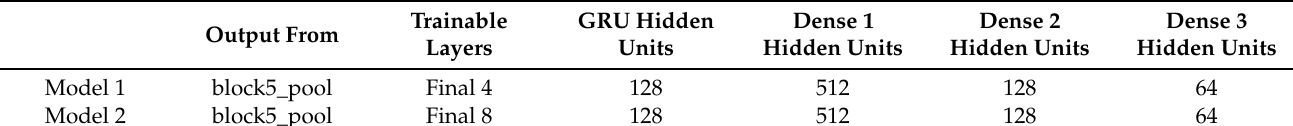
Table 5. VGG16–GRU-based models.